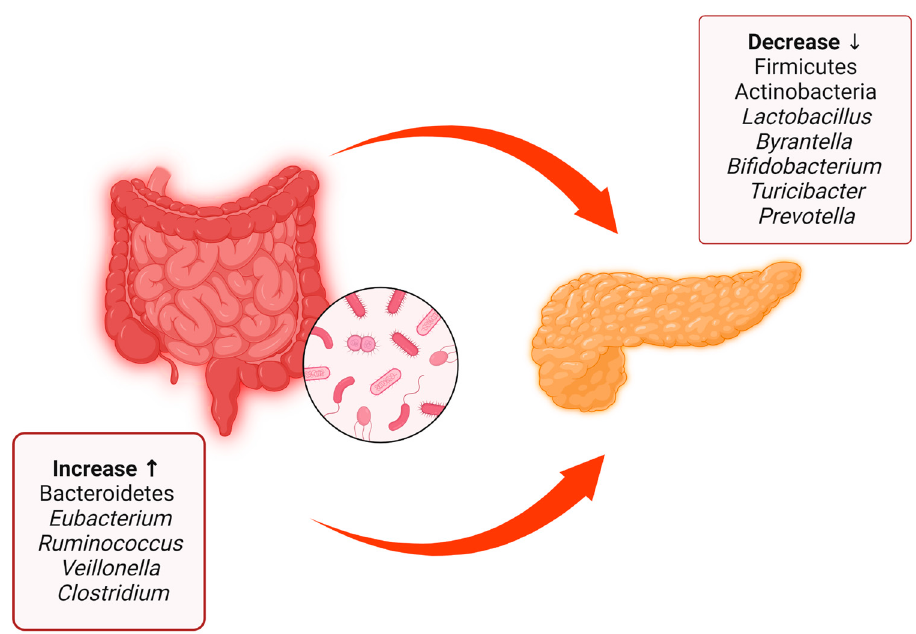
Figure 2. Summary of the main differences between the gut microbiota of patients with type 1 diabetes mellitus and healthy patients, with data obtained from both human patients and rats. There is a decrease in some bacterial species and phyla such as Firmicutes, Actinobacteria, Lactobacillus , Byrantella , Bifidobacterium , Turicibacter , and Prevotella accompanied by an increase in Bacteroidetes, Eubacterium , Ruminococcus , Veillonella , and Clostridium . Created with BioRender.com